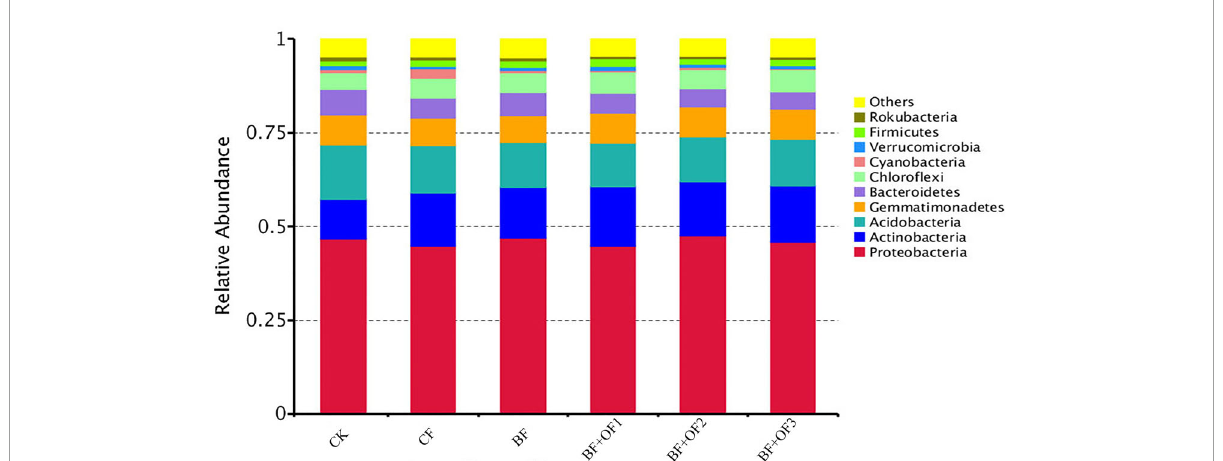
FIGURE3 Relative abundances of species at phylum level under different fertilization treatments. CK, no fertilizer, CF, chemical fertilizers (conventional dosage for this region); BF, balanced fertilizer (70% of total chemical fertilizer); BF + OF1, BF + OF2, and BF + OF3, balanced fertilizer plus 3,000, 6,000, 12,000 kg.ha − 1 bio-organic fertilizer, respectively.